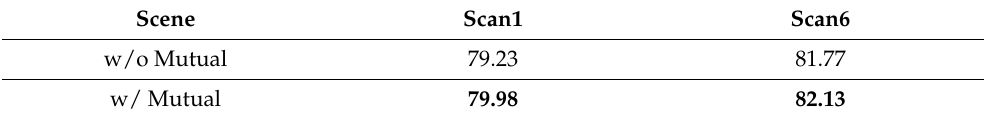
Table 2. Ablation study of the mutual strategy. The average F1-score (%) on the DTU dataset for two settings; w/o Mutual: using features computed from I to I (cid:48) only; w/Mutual: using features computed from both I to I (cid:48) and I (cid:48) to I . The best results are in bold. Scene Scan1 Scan6 w/o Mutual 79.23 81.77 w/ Mutual 79.98 82.13